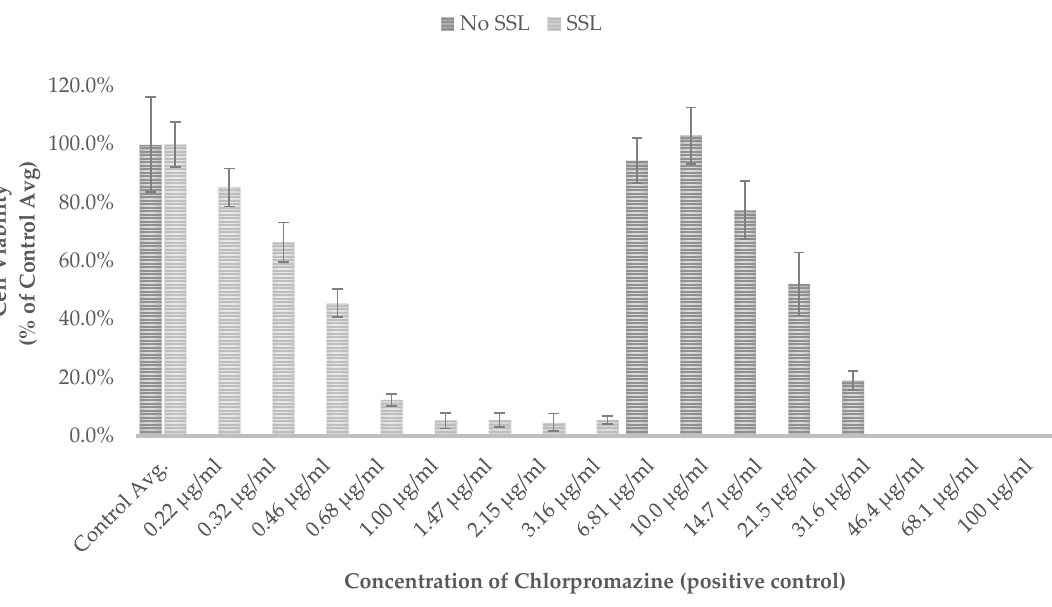
Figure 4. Positive control results. Cell viability by concentration of chlorpromazine (positive control), stratified by with and without solar simulated light (SSL).